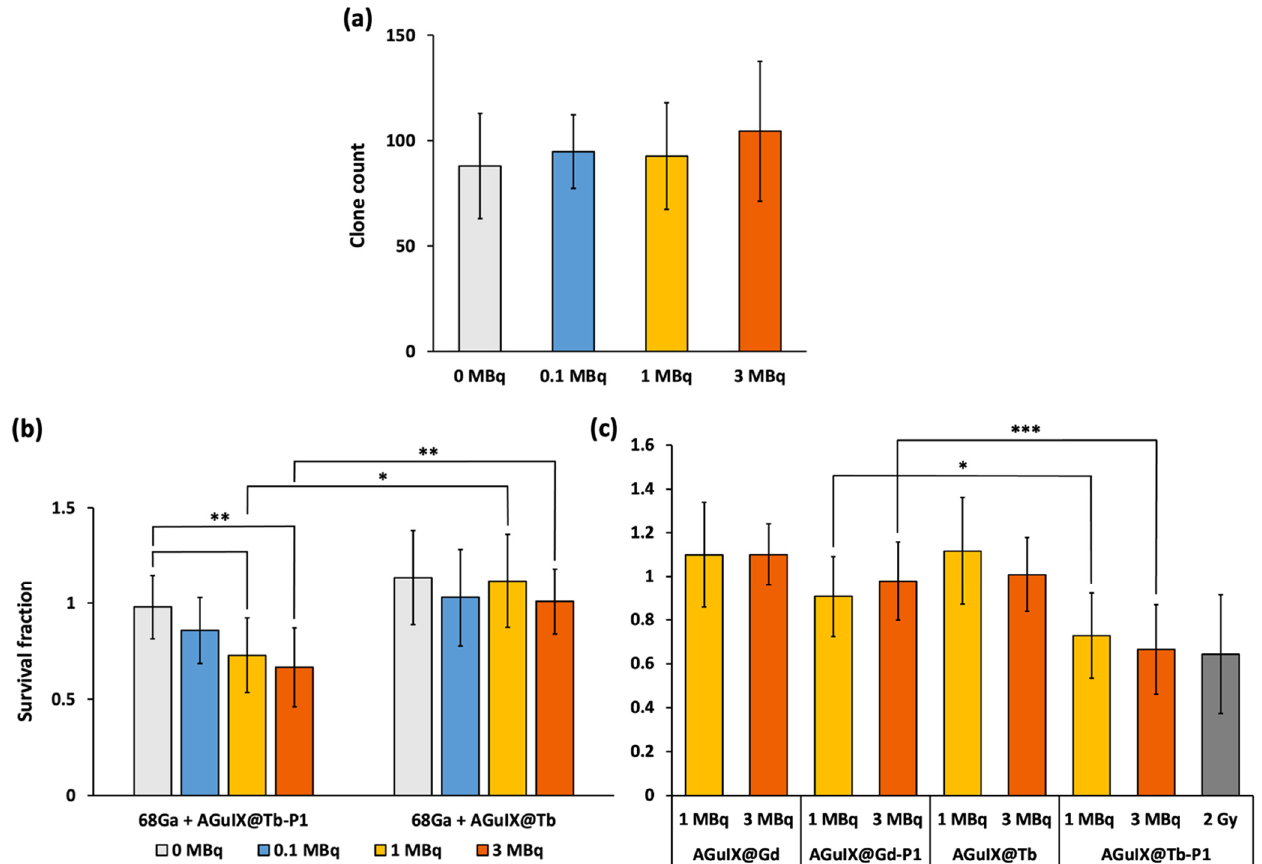
Figure 5. Impact of Gallium-68 deposition into U-251 MG cells. Anchorage-dependent clonogenic capability was assayed after cell exposure to increase concentrations of Gallium-68 ( 68 Ga) ( a ). Similarly, cells were pre-treated either in the presence of AGuIX@Tb-P1 or AGuIX@Tb ( b ) or in the presence of AGuIX@Gd or AGuIX@Gd-P1 ( c ), for 24 h, before exposure to 68 Ga for another 24 h delay. Cells were allowed to grow for 7 days. Cell clones obtained were counted after formol fixation and crystal violet staining. Clonogenic capabilities are expressed relative to control cells ( b , c ). In ( c ), cells pre-treated with AGuIX@Tb-P1 and irradiated at 2.0 Gy were used as a positive control of PDT efficiency on U-251 MG cell survival (grey box). Results are means ± S.D. (n = 12 wells/condition); significant difference, if any, was evaluated by Kruskal–Wallis test and post hoc by the Dunn test (*** p < 0.001, ** p < 0.01, * p < 0.05).